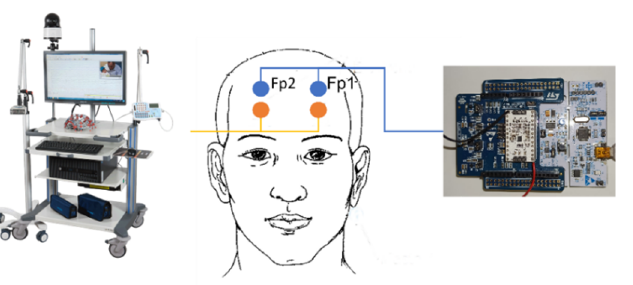
Figure 14. Electrodes positioning for EEG–EOG test for MicroMed ( left, orange electrodes ) and ST-Qvar ( right, blue electrodes ).